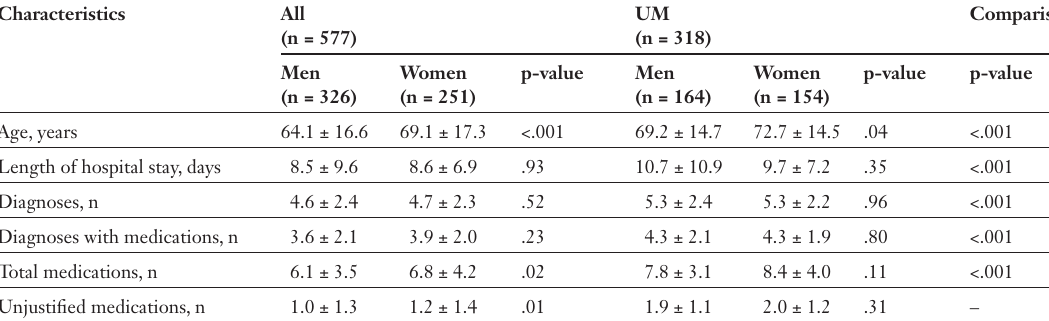
Characteristics of the whole study sample (ALL) and the collec- tive concerned with unjustified medica- tions (UM). Mean val- ues are given ± stan- dard deviation.The last column displayed the p-values resulting from a comparison with the two groups of patient: with and without unjustified